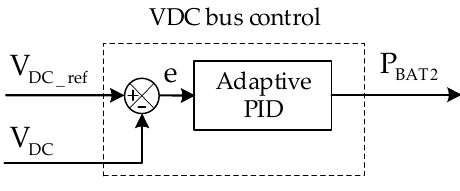
Figure 8. DC bus voltage control.